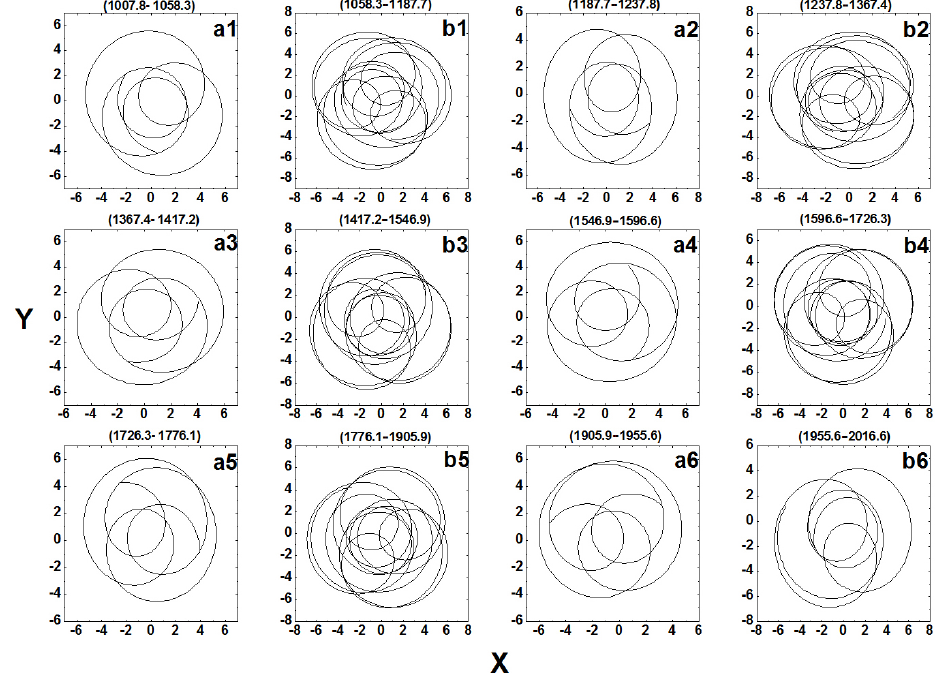
Figure 5. Life cycle diagrams of the trajectory of the planetary system from 1007.8 to 2016.6AD.